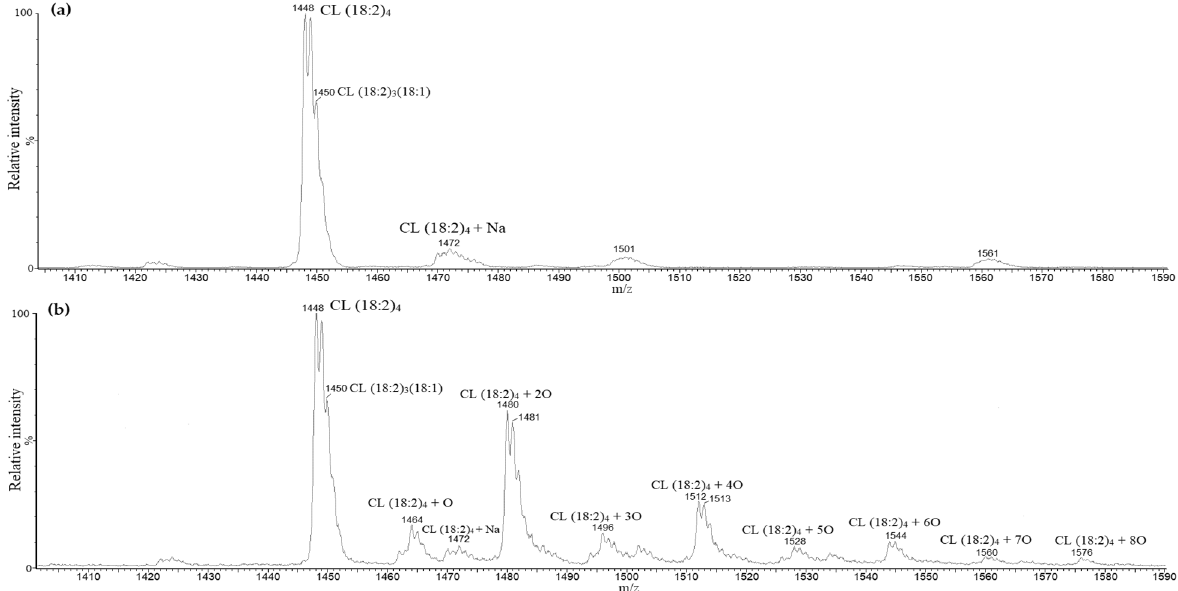
Figure 3. Cardiolipin standard mass spectra before ( a ) and after oxidation ( b ). After oxidation of cardiolipin standard, masses of tetralinoleoyl cardiolipin with an additional one to eight oxygen atoms were observed.